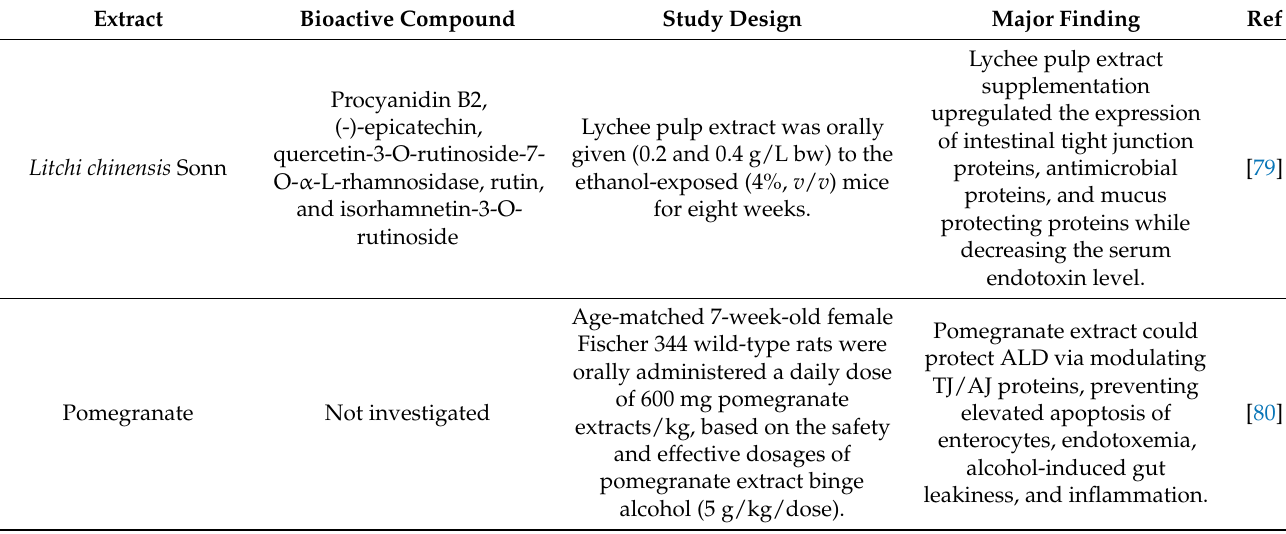
Table 1. Summary of the protective effect of various natural products against